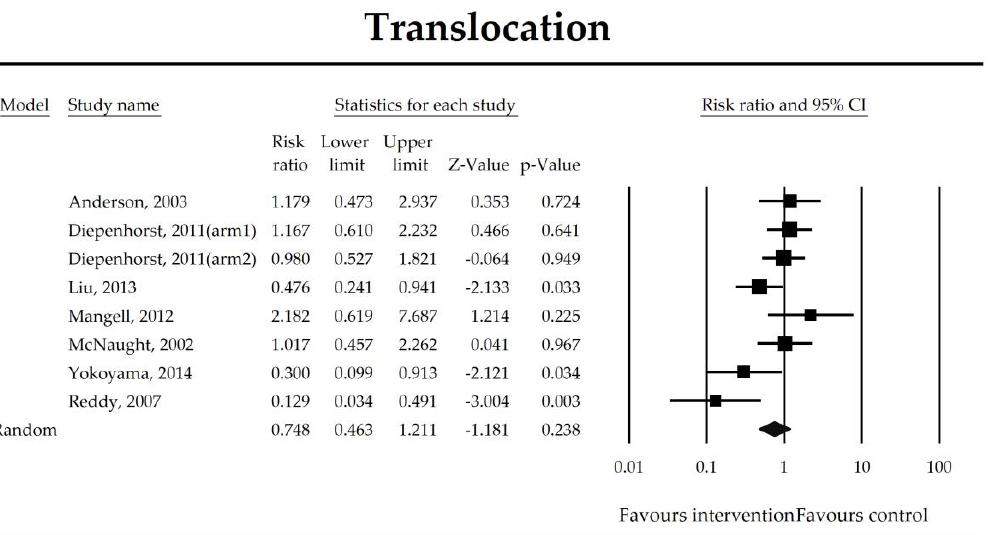
Figure 8. The effect size (standardized mean difference) for the concentration of propionic ratio in patients taking probiotics (intervention) vs. no probiotics (control).